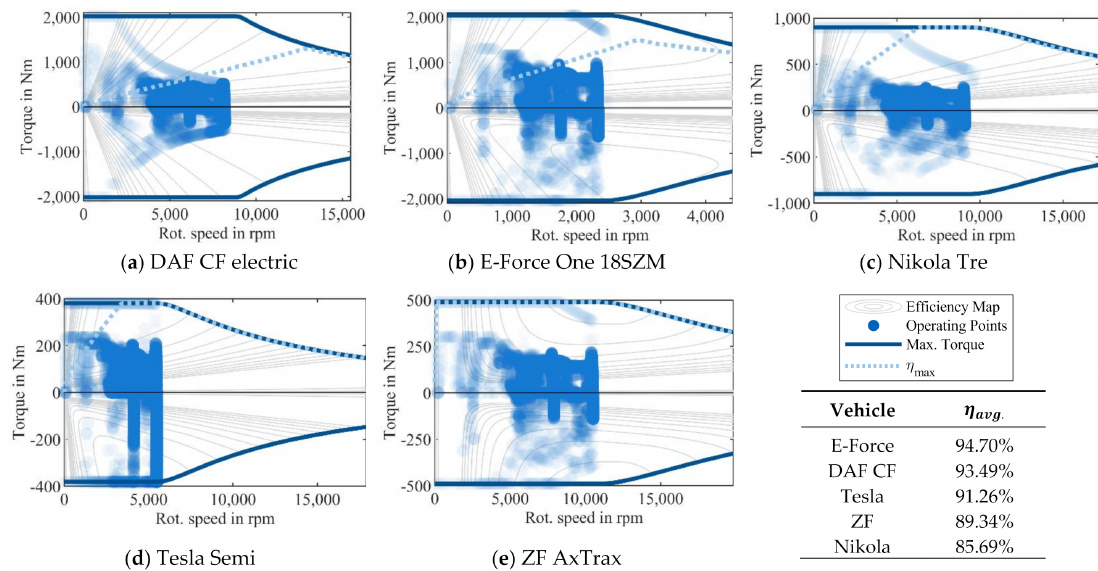
Figure 4. Simulation results of operating points, maximum, and average efficiency for regarded electric truck concepts ( a – e ) during the Truckerrunde driving cycle. The hyperbolic shapes are caused by the technical, maximum current of 500 A. The diagrams show that the operating points are located primarily at the vertical lines that represent the rotational speed around 80 km/h and 60 km/h, respectively. All concepts show most of the operating points near the rated rotational speed and thus at 85 km/h. This confirms the assumption made regarding the gear